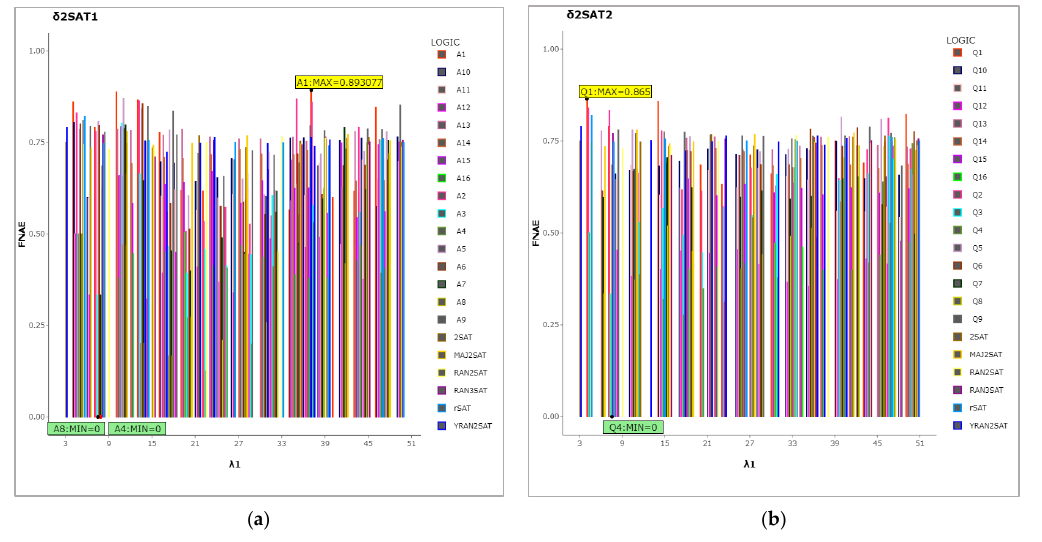
Figure 6. FNAE column representation for models in both types of logic ( a ) δ 1 2 SAT ρ , ( b ) δ 2 2 SAT ρ , and recently developed logic systems. Table 10. Maximum and minimum FNAE results for models in both types of logic δ 1 2 SAT ρ , δ 2 2 SAT ρ , and recently developed logic systems with details determined by Wilcoxon test for